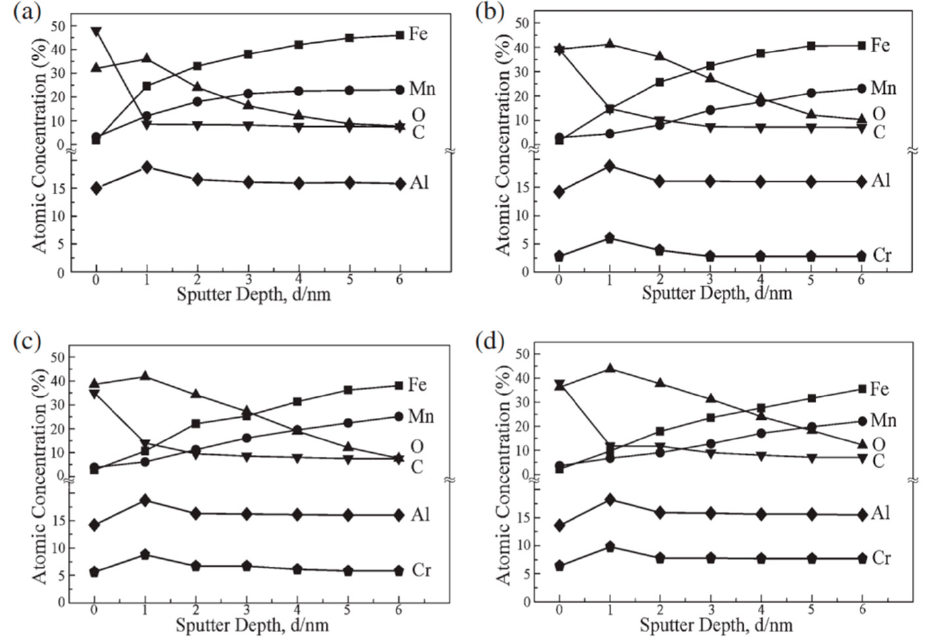
Figure 9. Auger depth profiles of the passive film present on Fe-28Mn-9Al-6Cr-1.8C alloy ( a ) 0Cr, ( b ) 3Cr, ( c ) 6Cr, and ( d ) 8Cr [102]. (Reproduced with permission from refs. [102]. Copyright (2010), Materials transactions).